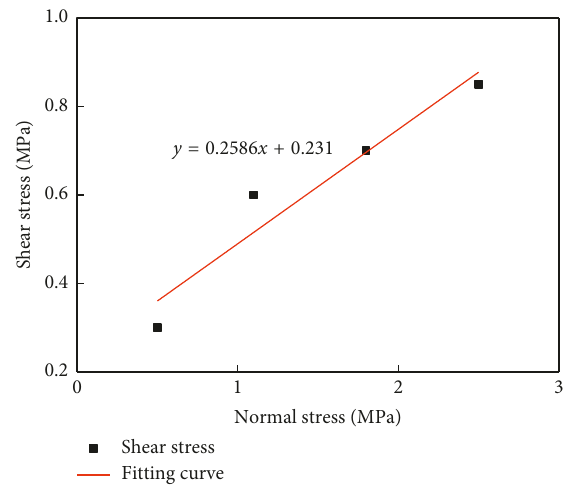
Figure 13: The relationship between the shear stress and the normal stress of the test point #3.